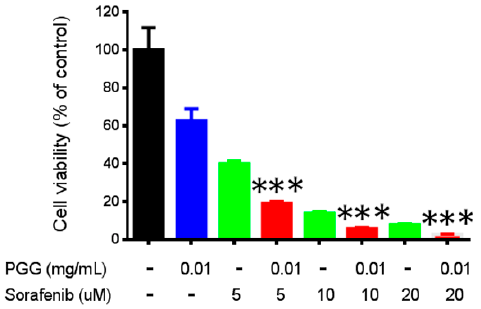
Figure 5. PGG sensitizes Huh7 cells to sorafenib treatment. Huh7 cells were treated with indicated concentrations of PGG (blue), sorafenib (green) or combinations (red) for 72 h. Cell viability was measured using the alamarBlue ® assay. The percentages of viable cells compared to the solvent control are plotted. Results are the means ± SD ( n = 3). *** p < 0.001 (Student’s t -test).